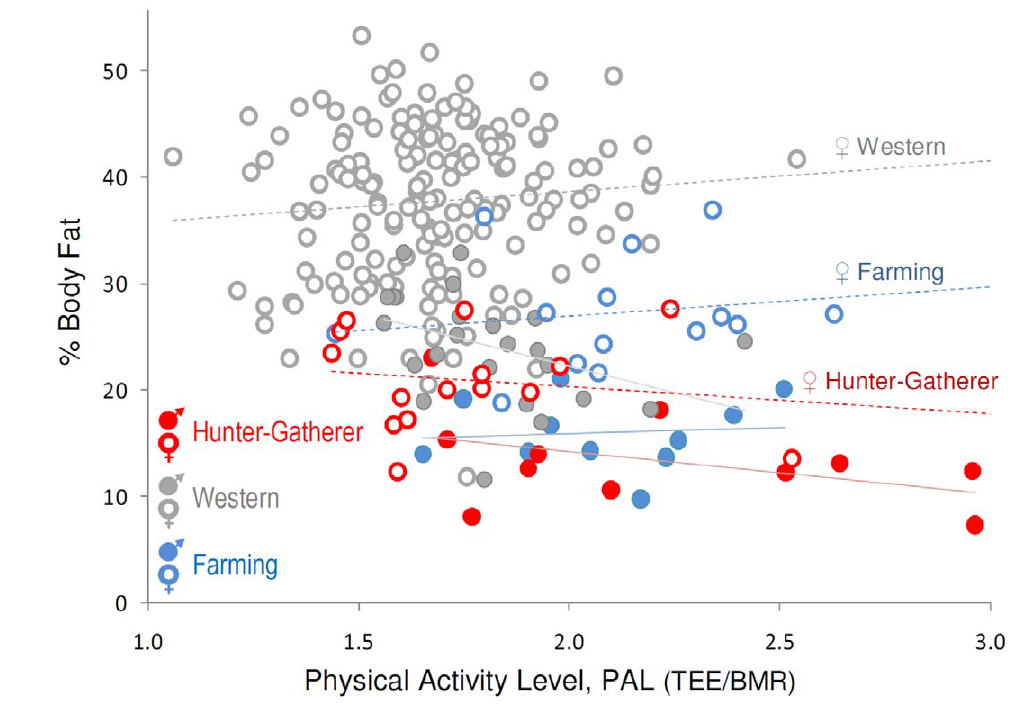
Figure 3. Percent body fat plotted against physical activity level, PAL. Hadza BMRs are estimated (Methods). Trendlines shown separately for each sex/lifestyle group; dashed lines indicate female groups. Group body fat differences are significant (p , 0.001), but slopes for %body fat versus PAL are not (Table S1).